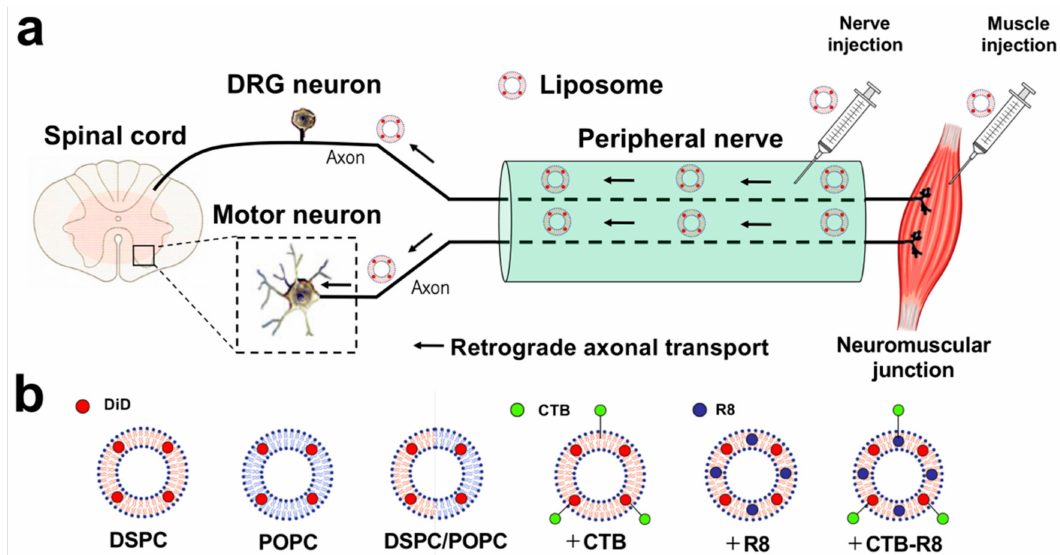
Figure 1. Schematic illustration of retrograde transport of liposomes from peripheral nerves or muscle to spinal cord motor neurons and DRG neurons. ( a ) Schematic overview of retrograde axonal transport of peripherally administered liposomes. ( b ) Schematic overview of liposomes consisting of different phospholipids and modified with CTB, R8, or